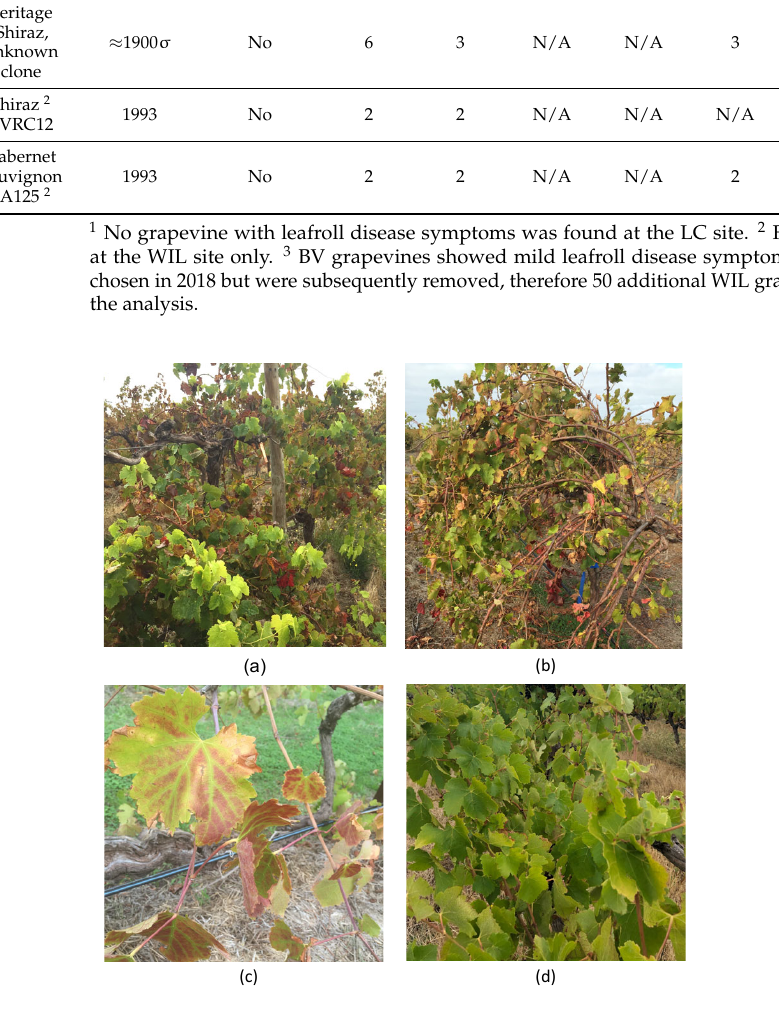
Figure 1. Symptoms of grapevine virus A (GVA)-infected Shiraz from the Willunga, Langhorne Creek and Barossa Valley sites. Symptoms of Shiraz-disease-affected Shiraz grapevines at ( a ) Willunga and ( b ) Langhorne Creek, and infected with GVA II variants ( c ) mild grapevine leafroll disease symptoms on an unknown clone of Shiraz that tested positive to GVA I variant and grapevine leafroll-associated virus 1 at Barossa Valley. ( d ) An asymptomatic Shiraz, clone BVRC12 at